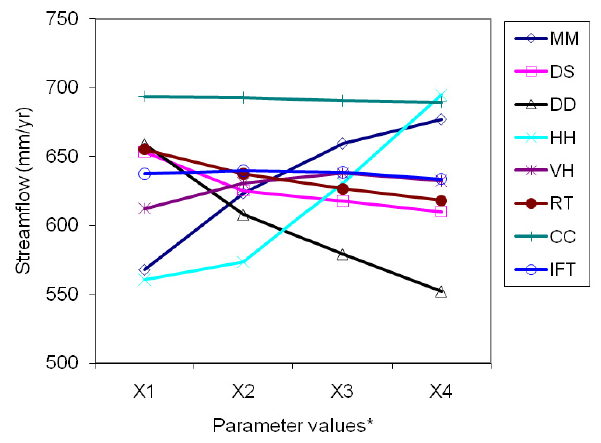
Fig. 3a. Sensitivity of streamflow to inputs *: X1 = 10, X2 = 30, X3 = 50 and X4 = 70 m 1/3 s -1 for Manning M (MM); 5, 25, 50 and 100 mm for detention storage (DS); 5, 25, 50 and 100 cm for Drainage depth (DD); 1x10 -6 , 4x10 -5 , 4x10 -4 and 5x10 -3 ms -1 for horizontal hydraulic conductivity (HH); 5x10 -7 , 5x10 -6 , 5x10 -5 and 1x10 -4 ms -1 for vertical hydraulic conductivity (VH); 30, 50, 70 and 90 cm for plant rooting depth (RT); 0.05, 0.2, 0.4 and 0.8 mm for coefficient of canopy interception (CC); 8x10 -6 , 8x10 -5 , 8x10 -4 and 1x10 -3 ms -1 for infiltration rate (IFT).